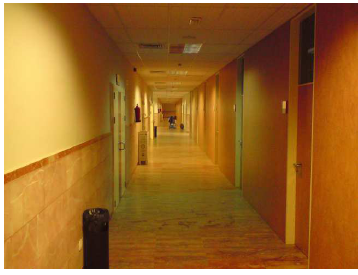
Figure 2. Corridor scenario